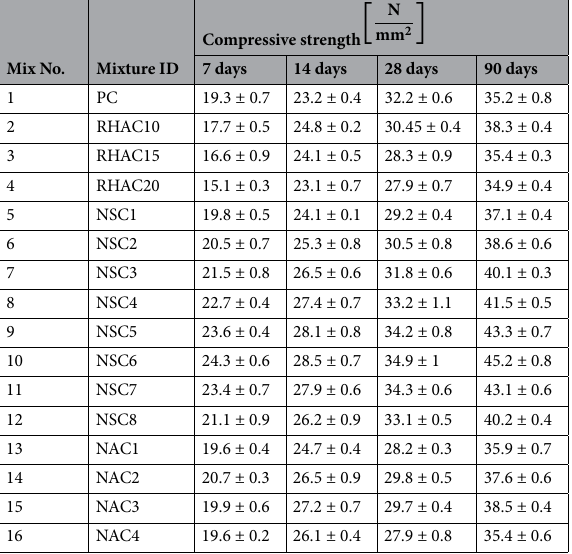
Table 7. Changing compressive strengths of concrete containing RHA, NS, and NA at various ages.